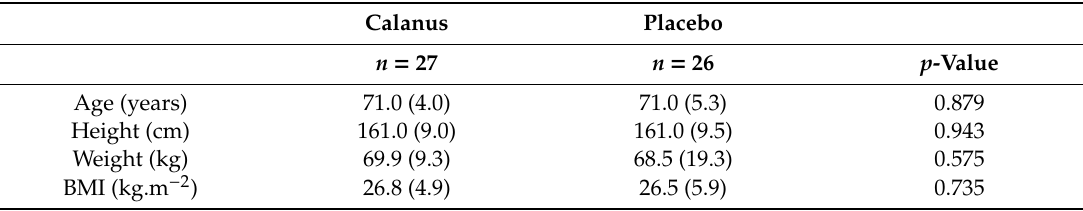
Table 1. Descriptive statistics (baseline